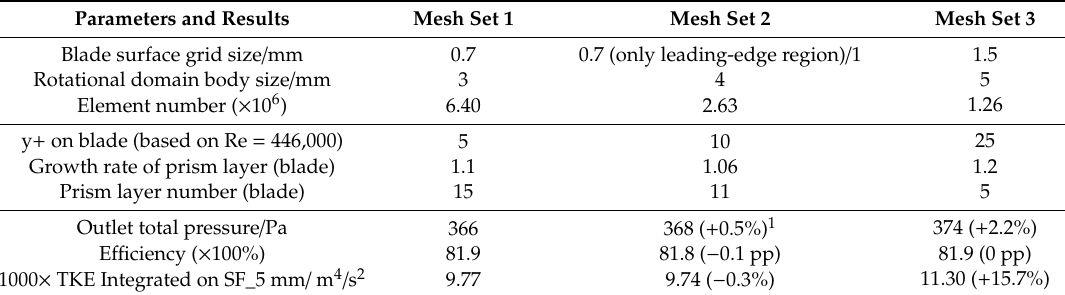
Table 3. Parameters and numerical results of three sets of mesh.